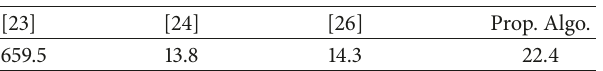
Table 5: Running time comparison (in seconds) of different algo-